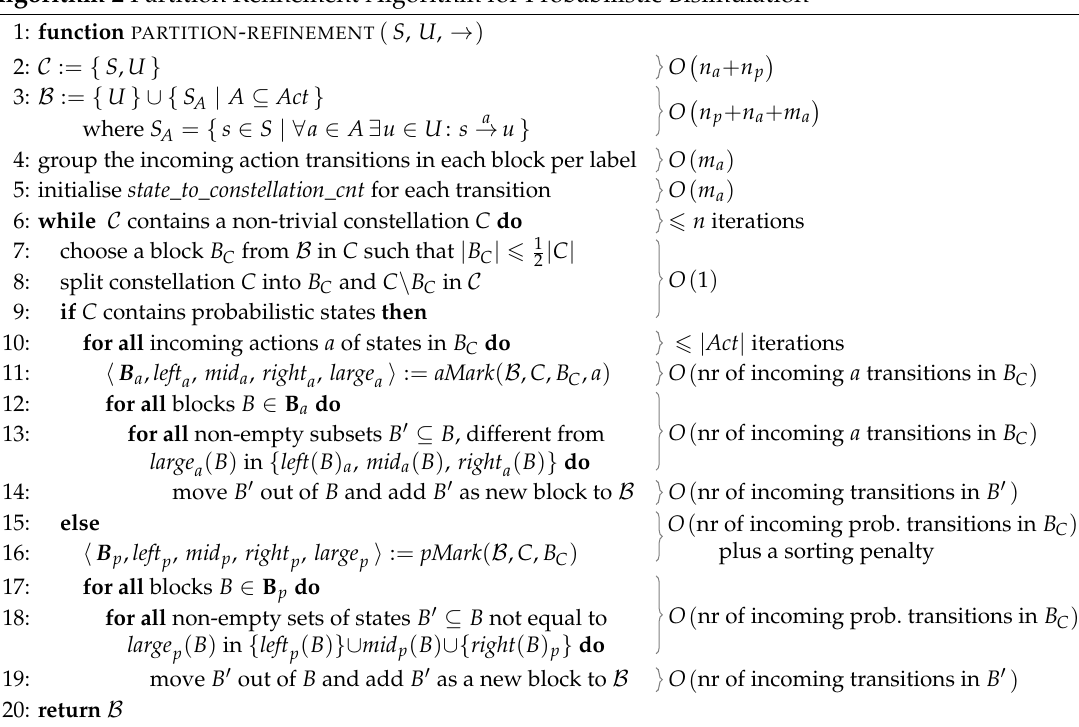
Algorithm 2 Partition Refinement Algorithm for Probabilistic